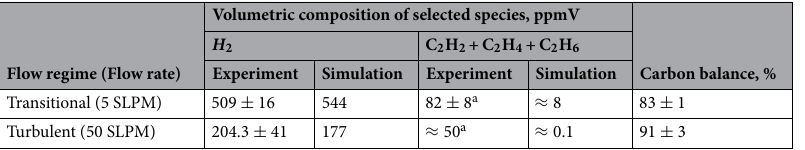
Table 4. Composition of the products in the product gas, and carbon balance. a Peaks of C 2 H x were clearly detected/identified, and quantified based on the nearest calibration point i.e, 100